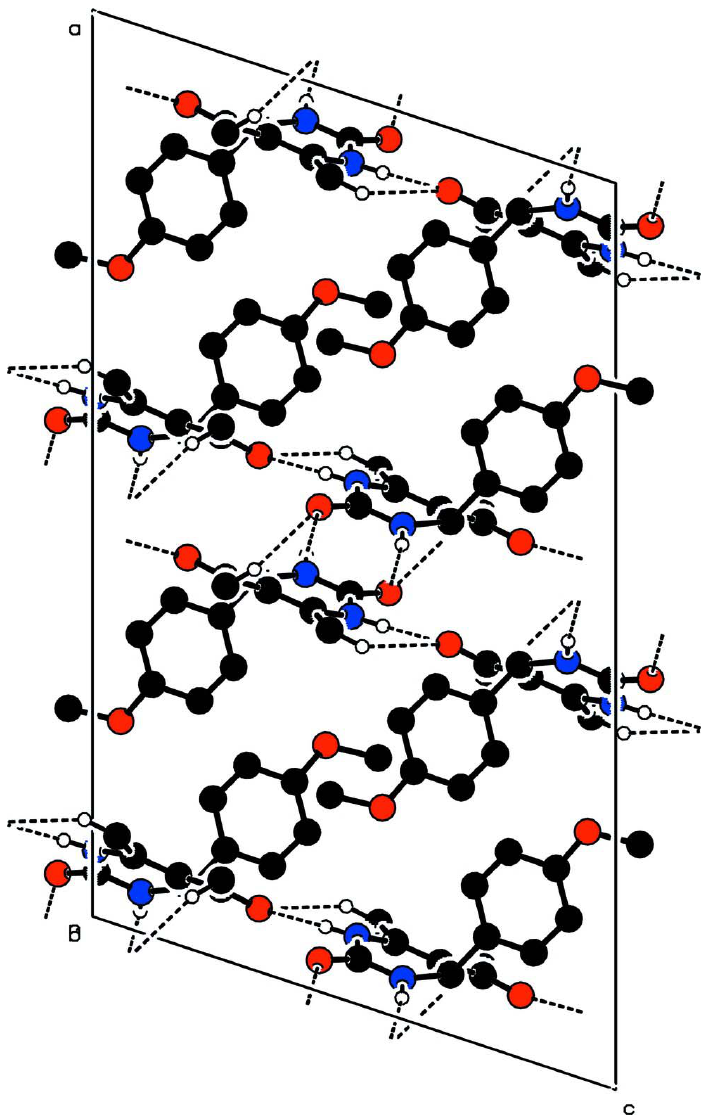
The packing of (I), viewed down the b axis. Dashed lines indicate hydrogen bonds. H atoms not involved in hydrogen bonding have been